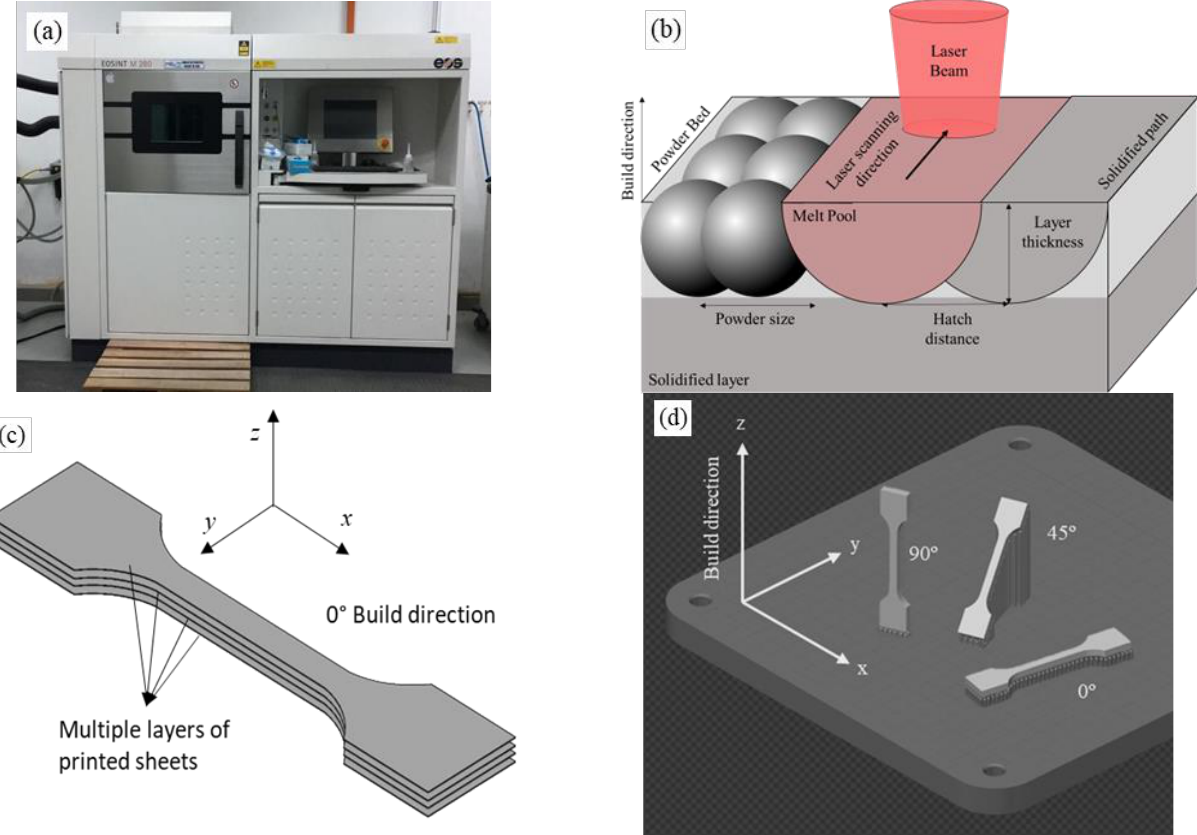
Figure 2. ( a ) EOSINT machine, ( b ) schematic diagram of processing parameters, ( c ) schematic diagram of layers and laser paths, and ( d ) build orientation of the specimen.